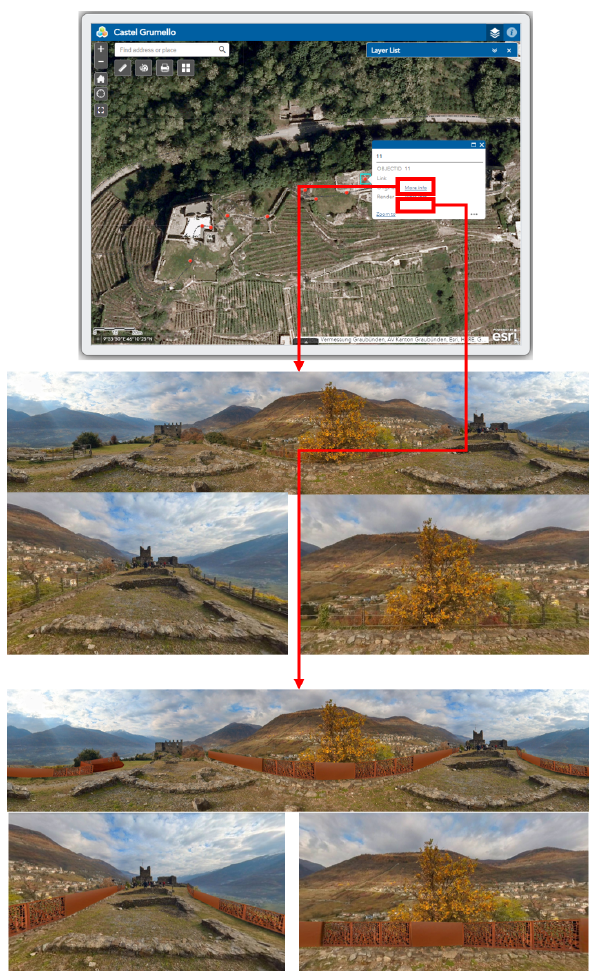
Figure 1: The web-GIS applications with both links to original and rendered equirectangular projection.